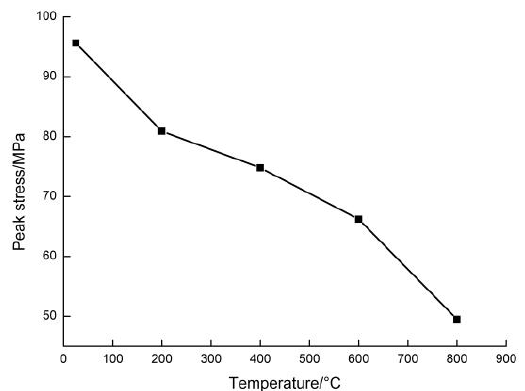
Figure 5. Peak stress in sandstone as a function of temperature.